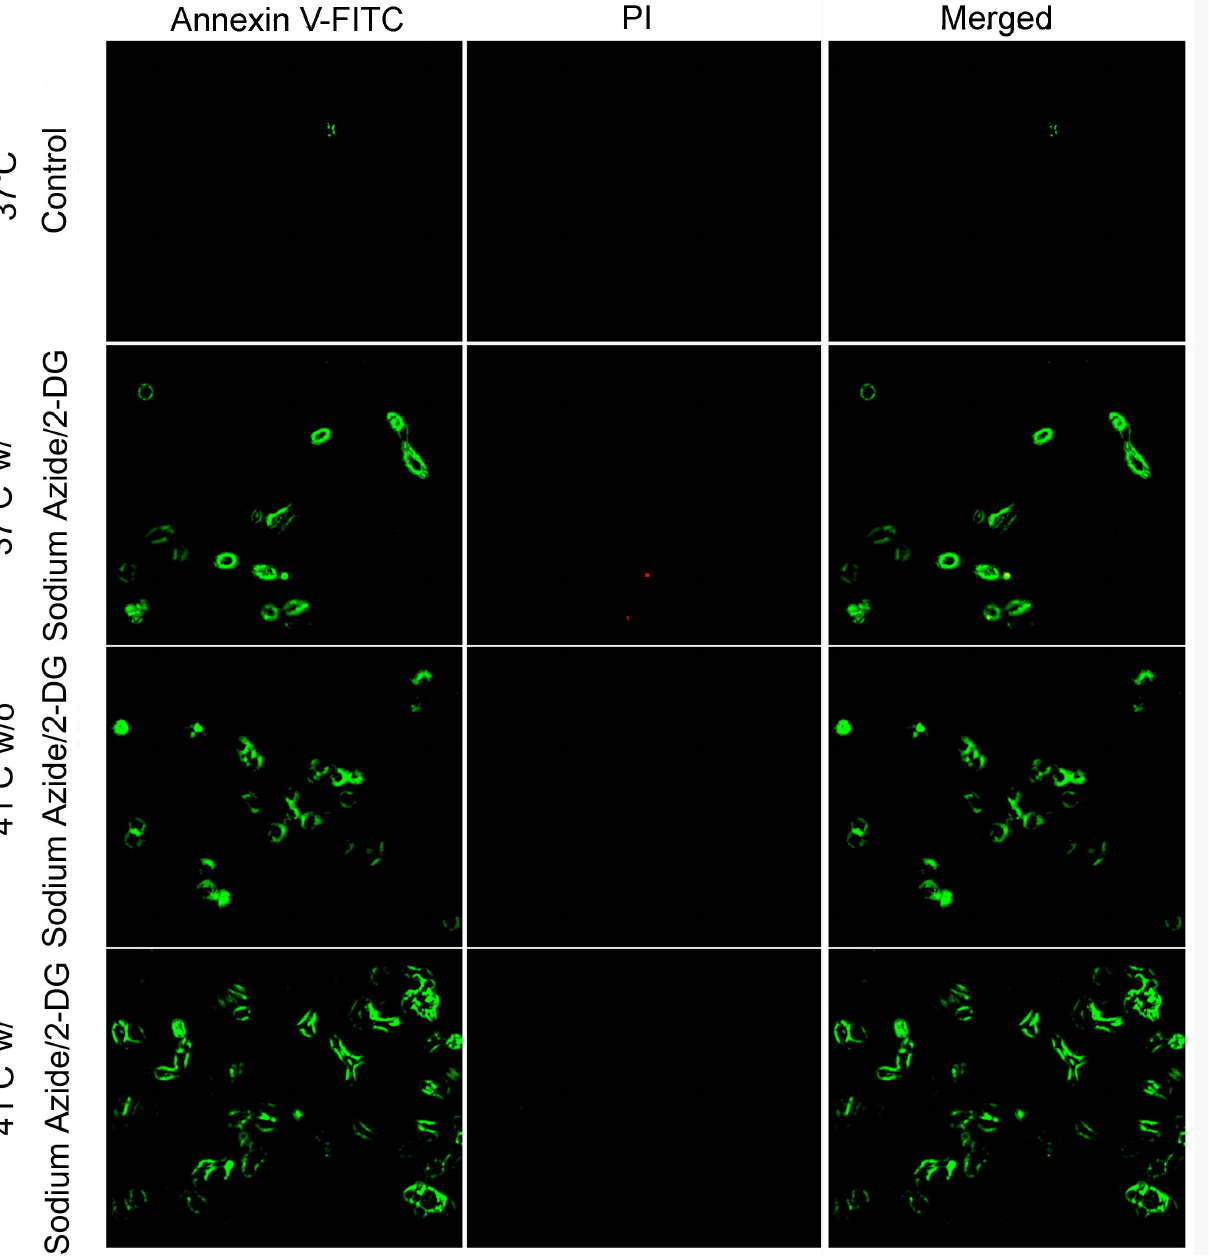
Figure 3. Apoptosis was detected with Annexin V-FITC and PI staining. Cells were double stained with Annexin V-FITC and PI after the treatments for 1 hour. Apoptosis with Annexin V-FITC positive staining (green fluorescence) was detected in cells treated with high temperature alone, sodium azide/2-DG alone or the combination of sodium azide/2-DG plus high temperature. Representative images were shown in the figure. w/: with; w/o: